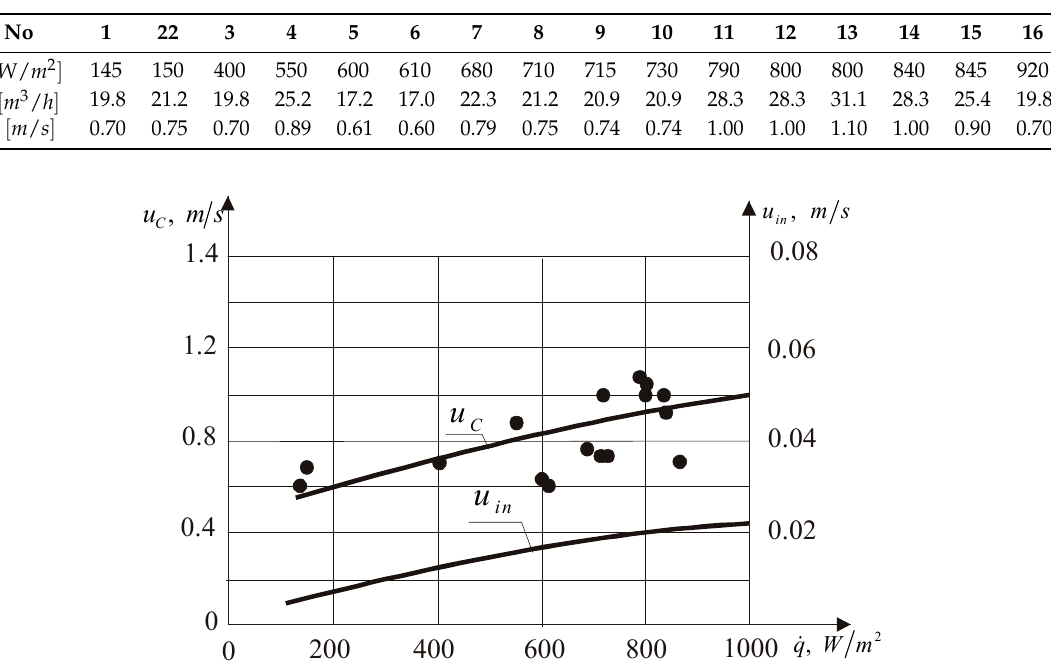
Figure 6. Experimental setup to validate the theoretical approach. Measured in mm. Table 2. Results of experimental measurements.